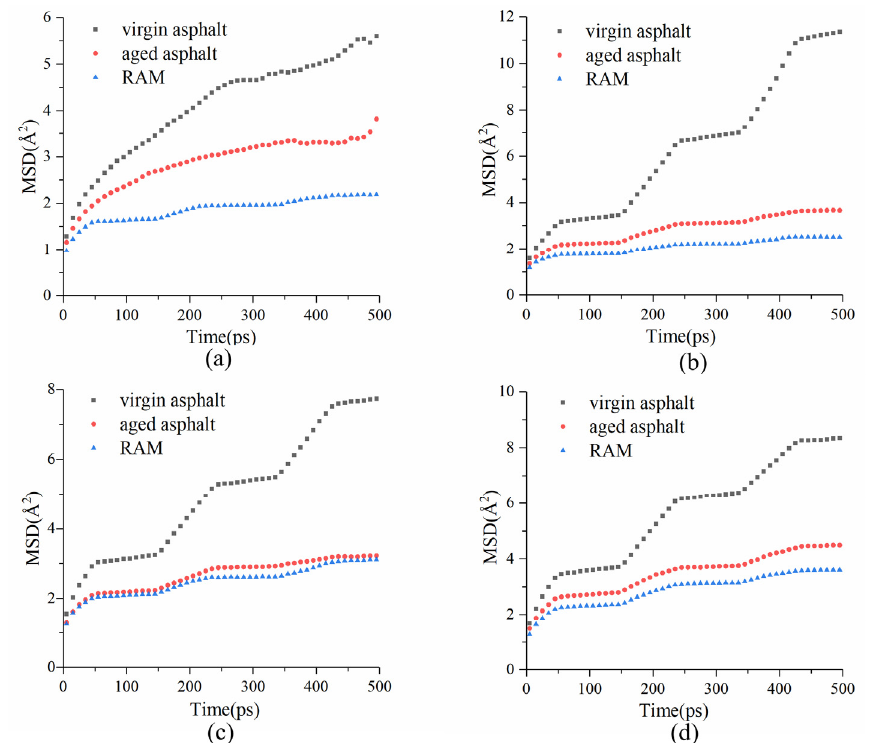
Figure 12. MSDs of SARA components: ( a ) asphaltene; ( b ) resin; ( c ) aromatic; ( d ) saturate.